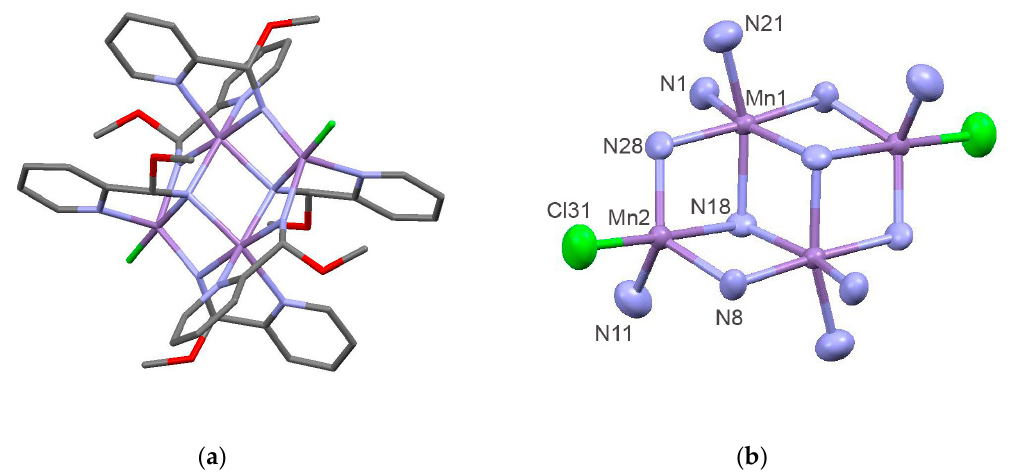
Figure 5. ( a ) Stick diagram of planar-diamond cluster 2. ( b ) Planar-diamond cluster core showing the atomic numbering scheme.